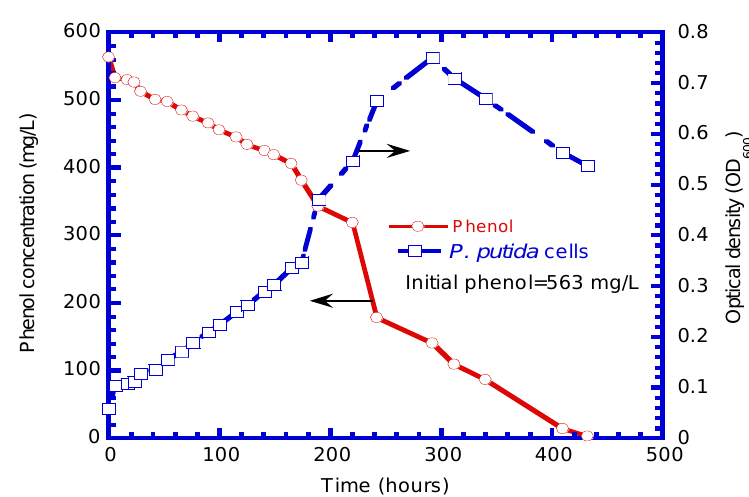
Figure 6. Batch kinetic test for phenol degradation and cell growth.